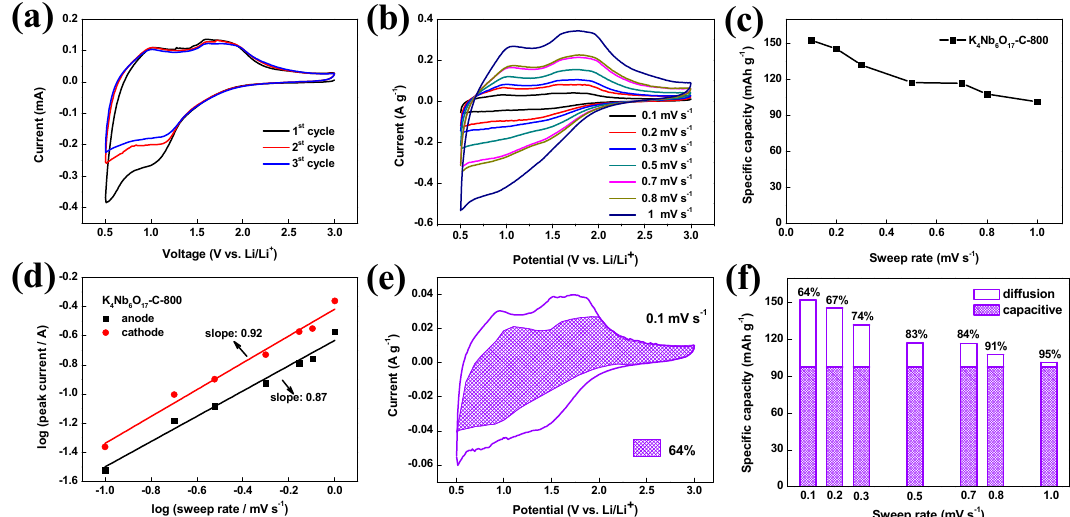
Figure 5. ( a ) The first three consecutive cyclic voltammetry (CVs) of the K 4 Nb 6 O 17 -C-800 at a scan rate of 0.5 mV s − 1 . ( b ) The CV curves of K 4 Nb 6 O 17 -C-800. ( c ) Plotting of capacitance versus sweep rate. ( d ) Determination of the b value of anode and cathode peak currents. ( e ) Total current (solid line) and capacitive current (shade region) at 0.1 mV s − 1 . ( f ) The capacitive contribution of K 4 Nb 6 O 17 -C-800.